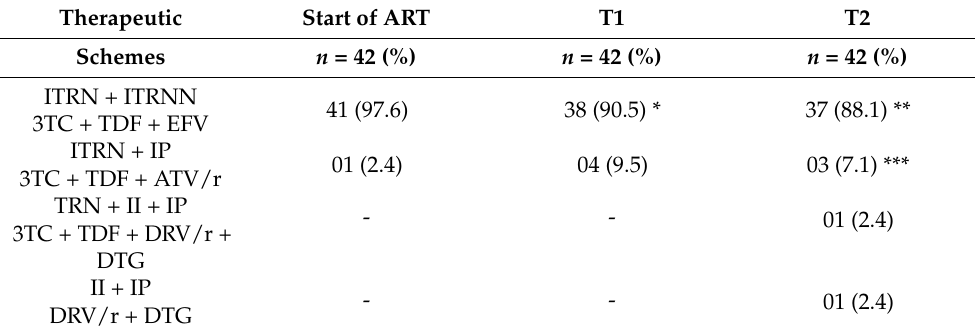
Table 5. Distribution of PLHIV according to the antiretroviral therapy regimen used. Therapeutic Start of